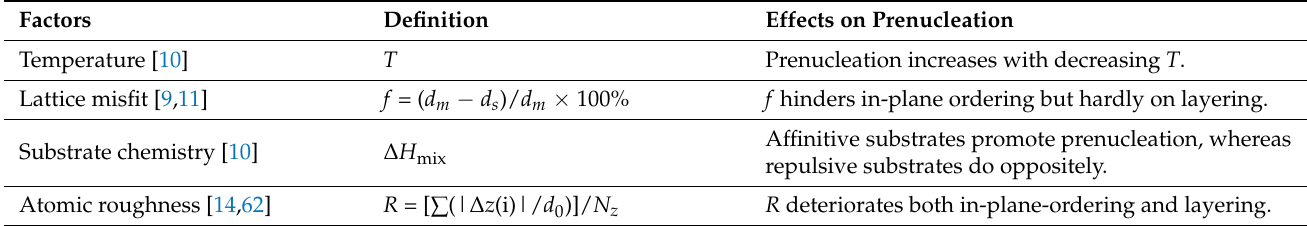
Table 3. Factors affecting the prenucleation at liquid–metal/solid-metal